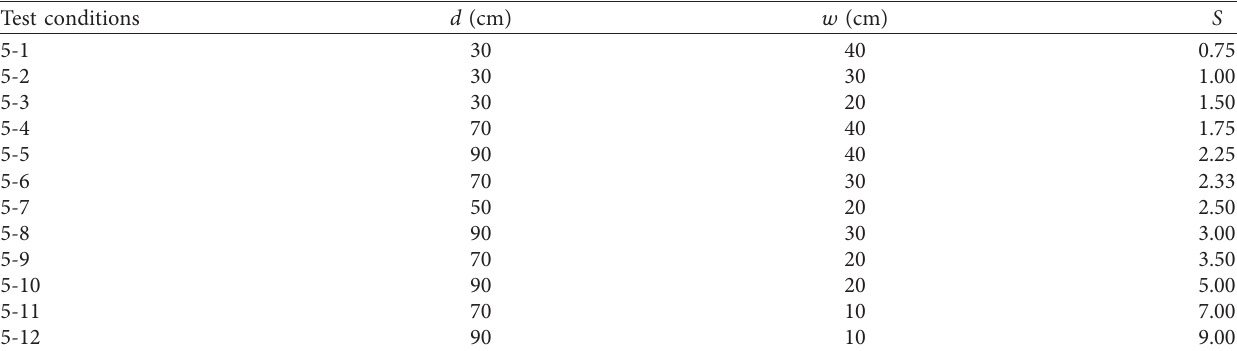
Table 13: Test arrangement for the parameter S